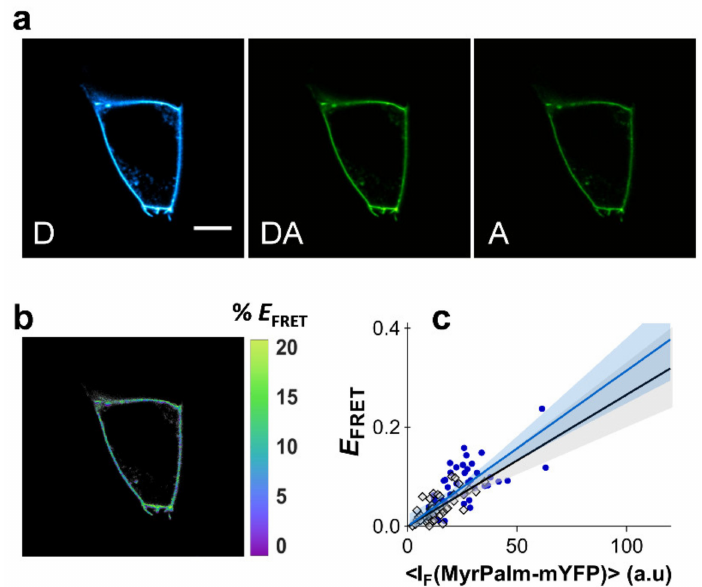
Figure 2. Dependence of FRET efficiency with acceptor intensity. FRET microscopy of HEK293T and HeLa cells co-transfected with myrpalm-mCFP and myrpalm-mYFP. ( a ) Example of confocal data acquired according to the three-filter cube method in HEK293T cells: D—donor channel, DA—FRET channel, A—acceptor channel. Scale bar = 5 µ m. ( b ) FRET efficiency image. ( c ) Dependence of E FRET with myrpalm-mYFP fluorescence intensity for HEK293T (blue circles) and HeLa cells (gray diamonds). Each data point corresponds to the FRET signal at a segment of the plasma membrane of an individual cell (at equatorial optical sections). Lines represent the global least-squares fit of Equation (1) to both data sets, and the corresponding 95% confidence intervals are shown as shaded areas (see Section 4 of the Supplementary